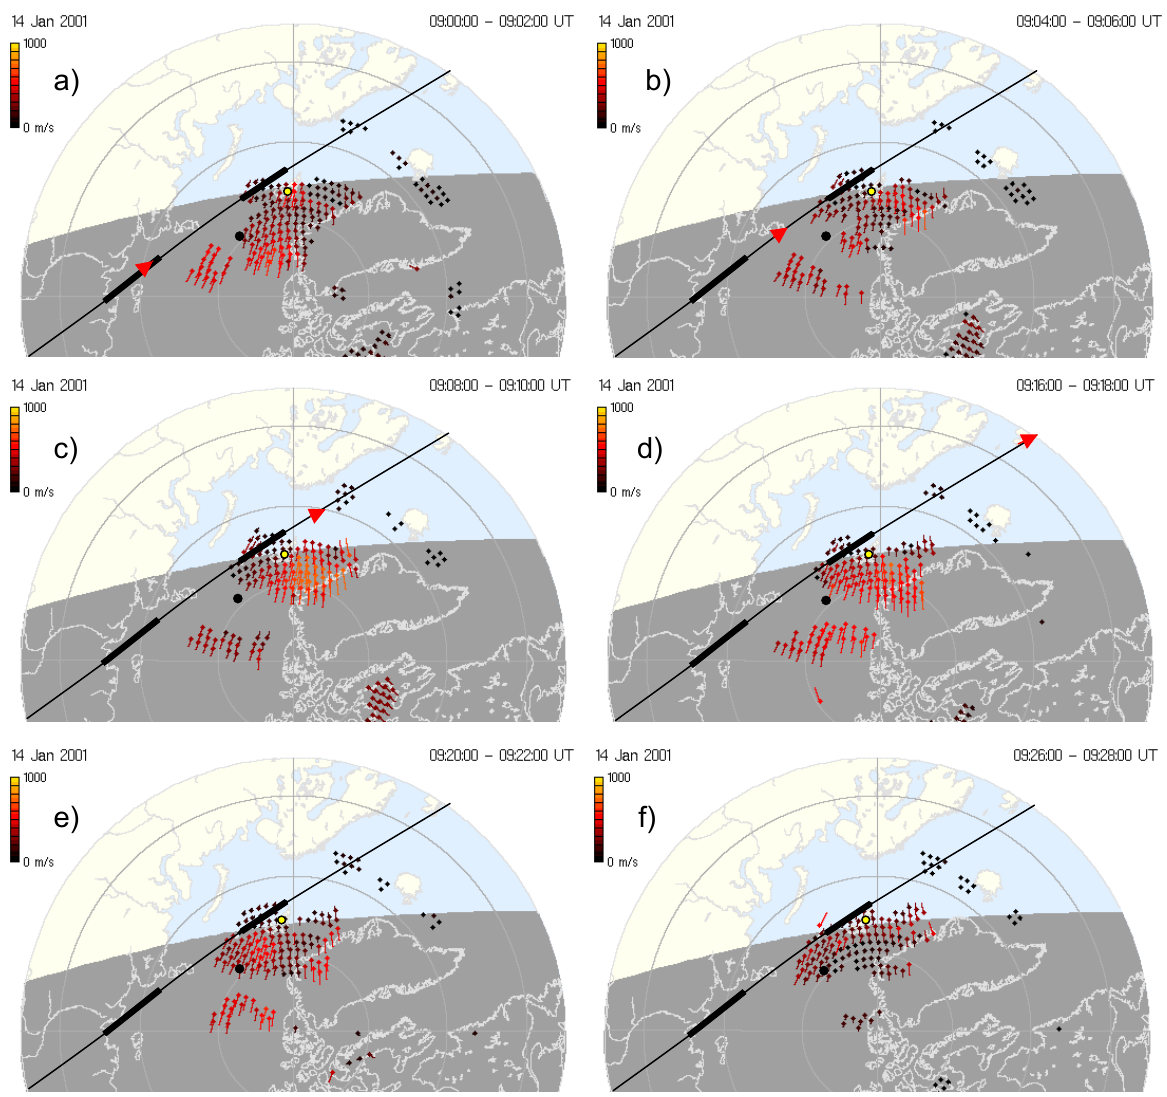
Fig. 9. SuperDARN observations of the line-of sight plasma velocities seen at 09:00–09:30. Selected frames are for 2min scans centred on: (a) 09:01, (b) 09:05, (c) 09:09, (d) 09:17 (e) 09:21, and (f) 09:27. The orbit of DMSP-F12 is shown in each case, with the auroral oval and cusp locations marked: the red arrow gives the location of the satellite in each case. The ESR field-aligned beam is shown as a yellow